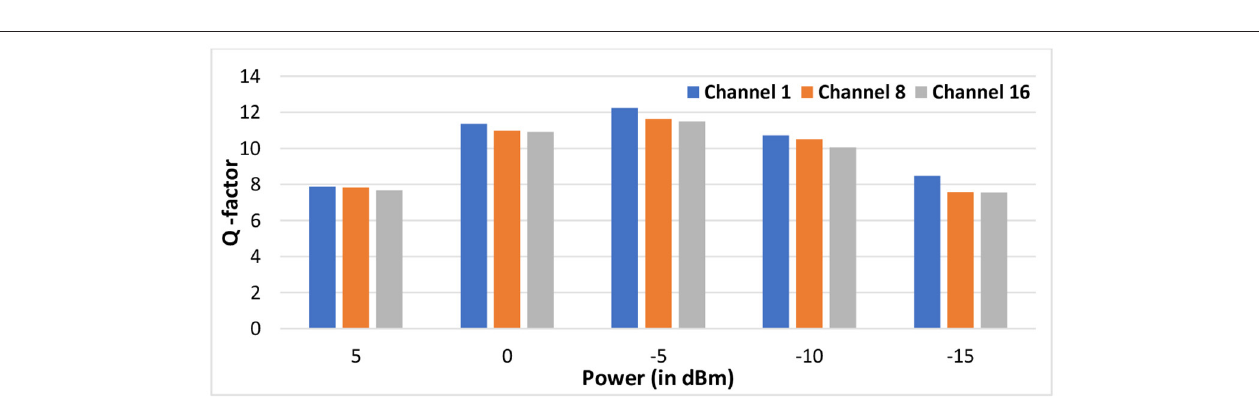
FIGURE 11 | The eye diagrams for WDM-based RoF system with DCF and FBG for 50 GHz channel spacing. (A) The eye diagrams at channels 1, 8, and 16 at − 5 dBm input power. (B) The eye diagrams at channels 1, 8, and 16 at − 15 dBm input power.